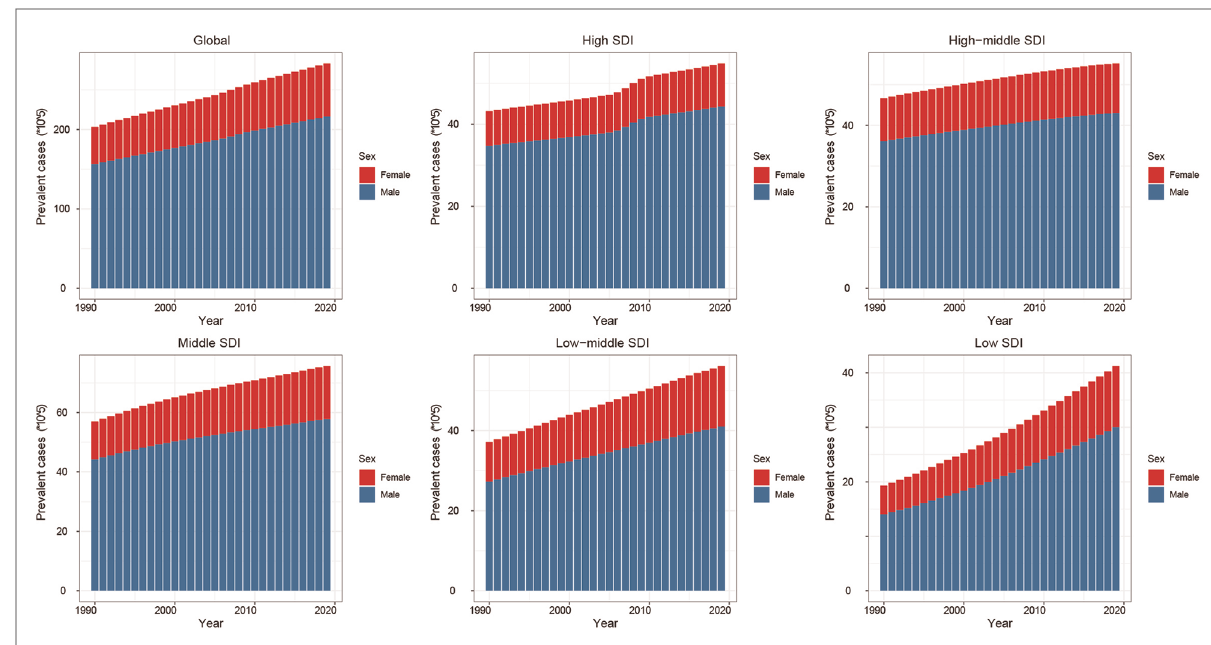
FIGURE 3 Global prevalence of autism spectrum disorders (ASD) by sex and socio-demographic index (SDI) quintiles from 1990 to